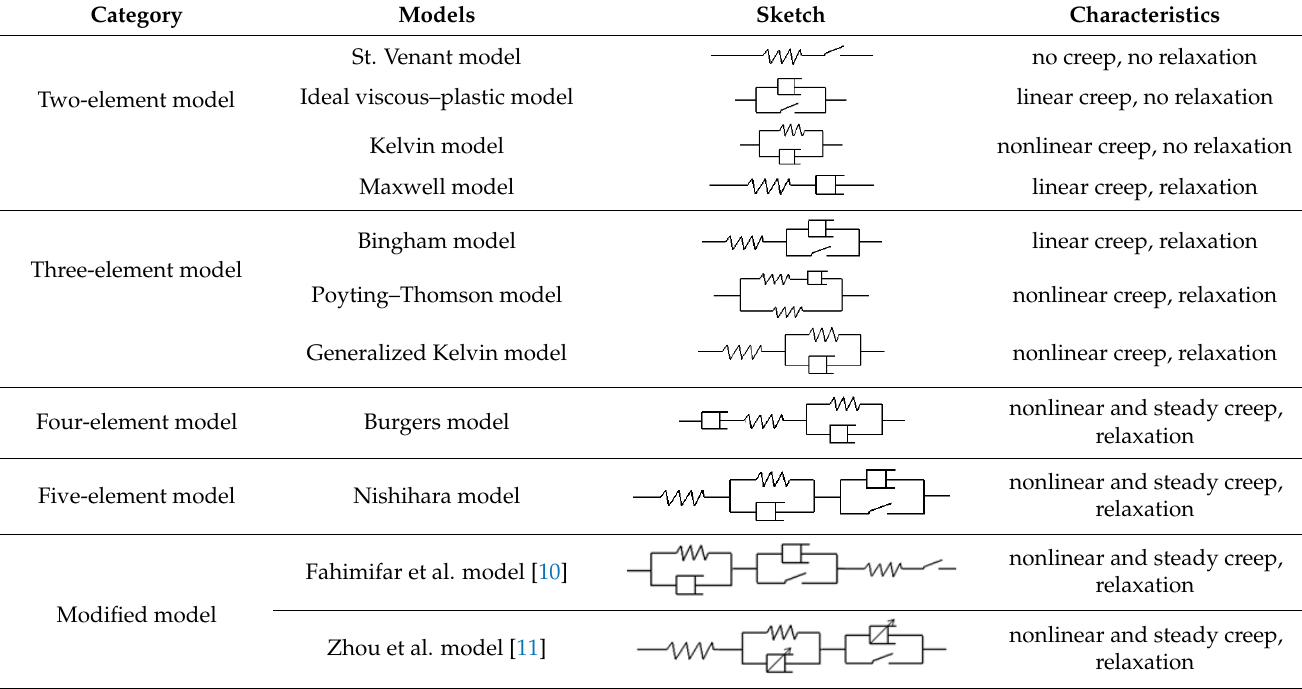
Table 1. The traditional and modified model comparisons.